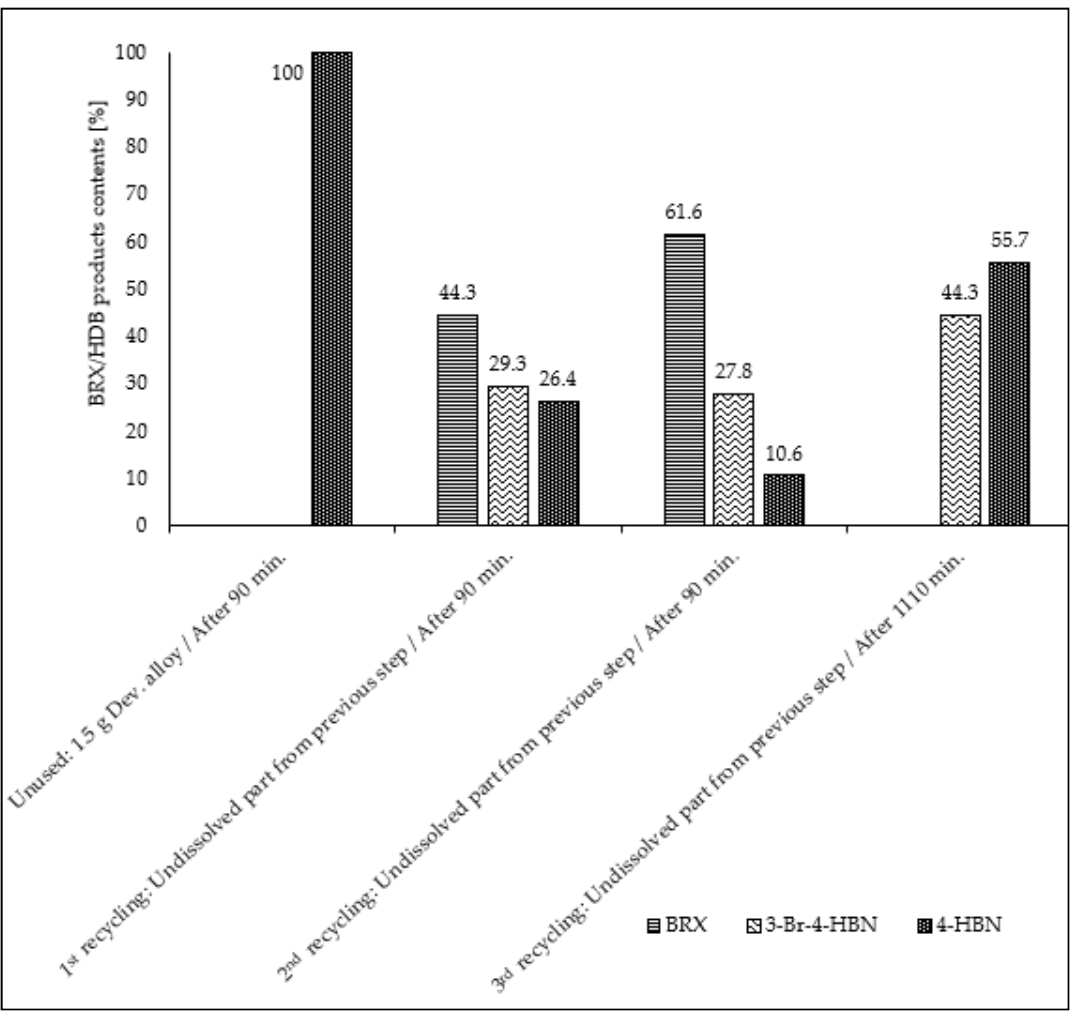
Figure 6. Comparison of HDB efficiencies involving unused and/or recycled Dev. alloy added to the solution of 2.5 mmol BRX + 50 mmol NaOH in 100 mL H 2 O.